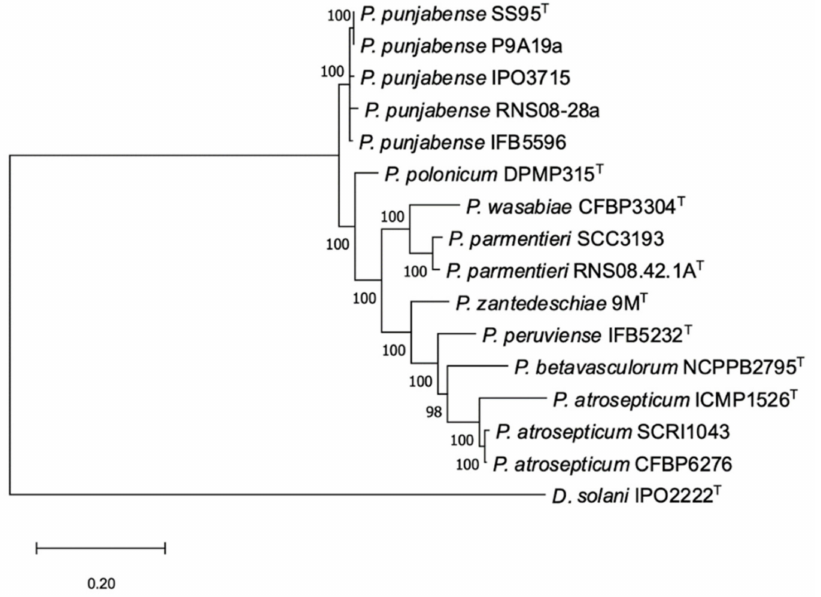
Figure 2. The phylogenomic analysis of P. punjabense strains and the most closely related species of the genus Pectobacterium , based on 399 most conserved universal proteins. The maximum likelihood tree was constructed using the PhyloPhlAn computational pipeline (https://huttenhower.sph.harvard. edu/phylophlan accessed on 18 January 2021). The gene sequences of D. solani IPO2222 (CP015137) were used as an outgroup. Bootstrap values were calculated from 1000